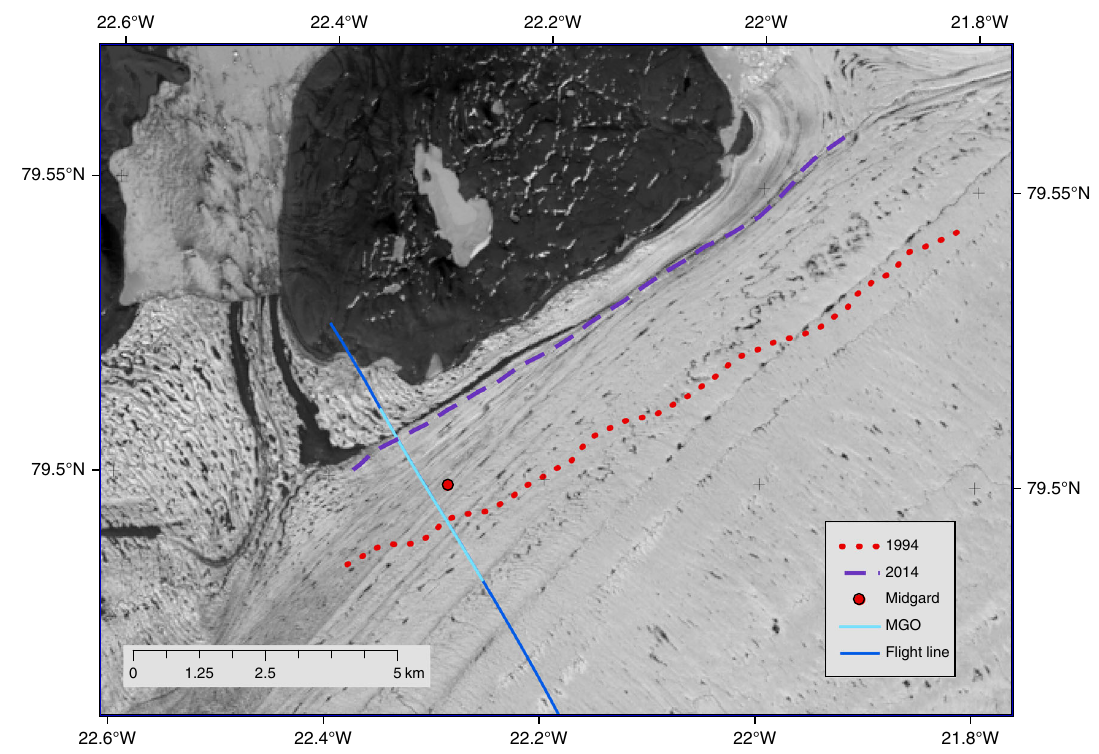
Fig. 4 Migration of Midgardsormen from 1994 until 2014. Position of Midgardsormen in 1994 (red dotted line) and 2014 (dark purple dashed line). The red dot represents the location of the seismic experiment at Midgardsormen in 1998, while the blue line indicates the fl ight line of the airborne radar in 1997 and the elevation pro fi le of the Icebridge ATM in 2012 (background image: Landsat 8 scene from 12 Jul 2014). The light blue section of the fl ight line represents the part displayed in Fig.